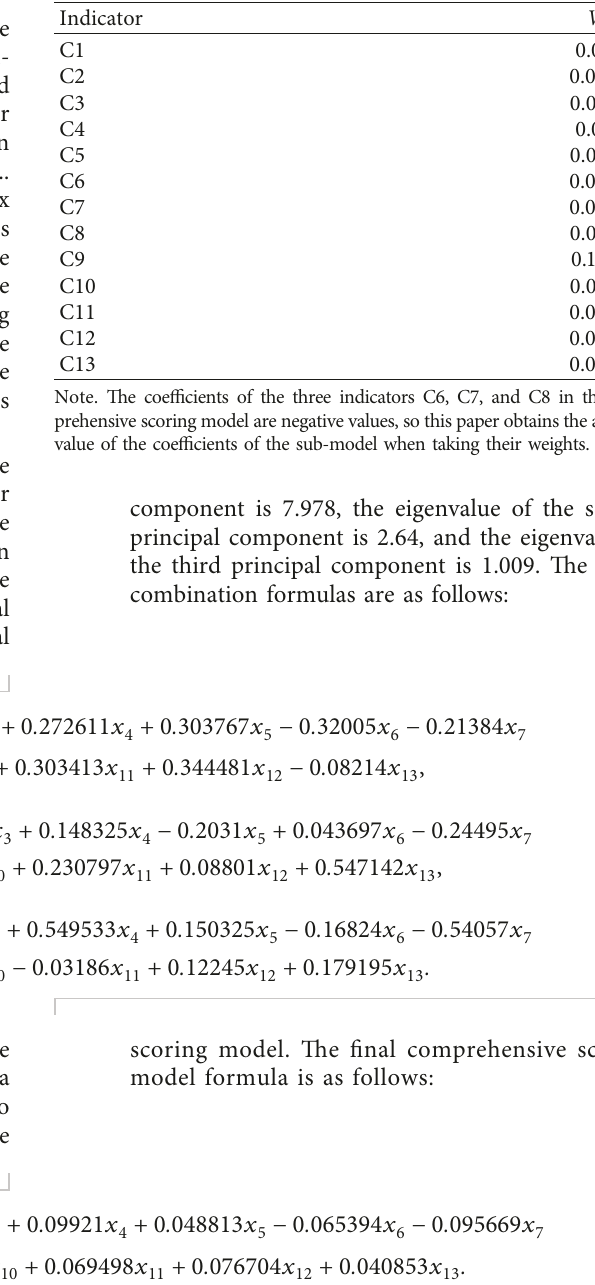
Table 2: Objective weights of early warning indicators based on PCA